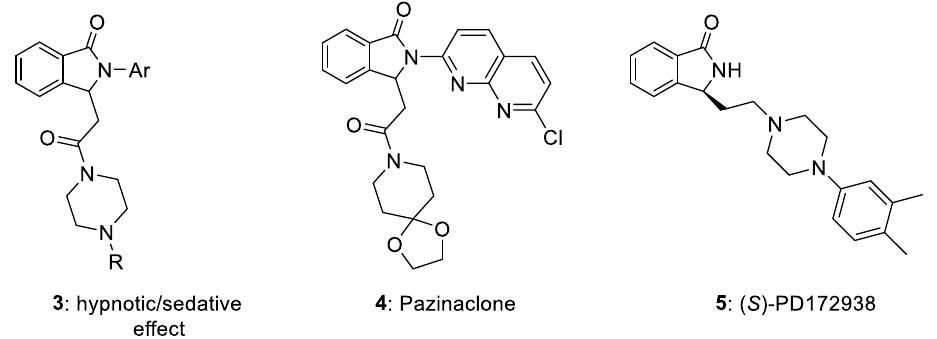
Figure 2. Some bioactive